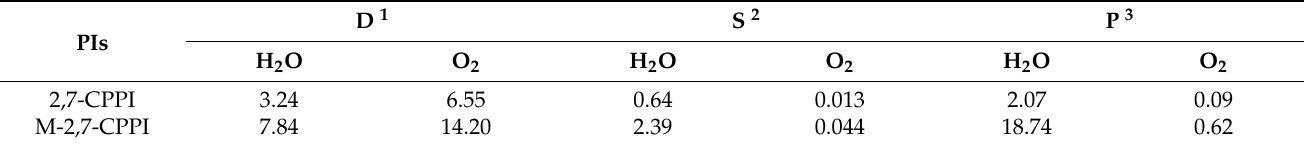
Figure 13. Sorption sites of O 2 and H 2 O in M-2,7-CPPI and 2,7-CPPI. (Red, yellow, and blue stand for low, medium, and high adsorption amounts, respectively.). 3.8.3. Gas Permeability The permeability coefficient (P) was calculated with the equation P = D × S as elu- cidated by the solution-diffusion mechanism [44] and is shown in Table 5. The simulated P of O 2 and H 2 O in the two isomeric polyimides displayed the same variation trend with the experimental values, proving the viability of molecular simulation on gas permeabil- ity. Altering the linkage from para to meta impeded the dense chain stacking and thus increased free volumes, promoting the gases diffusivity and solubility. Consequently, the meta -based isomer M-2,7-CPPI showed increased gas permeability and therefore reduced barrier properties. 4. Conclusions A diamine (M-2,7-CPDA) bearing carbazole moiety was synthesized by a two-step method. This diamine is an isomer of our previously reported diamine 2,7-CPDA, in which the substituted position of amino is altered from para to meta . Both diamines were polymerized with PMDA to obtain two isomeric polyimides (M-2,7-CPPI and 2,7-CPPI). The two isomeric PIs showed comparable thermal stability. Meta -linked M-2,7-CPPI had lower mechanical properties and higher CTE than para -linked 2,7-CPPI. Molecular sim- ulation, PALS and WAXD were employed to explore the effect of molecular isomerism